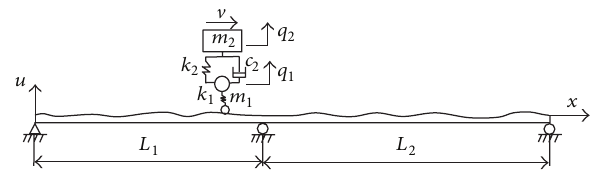
Figure 1: A typical vehicle-bridge interaction